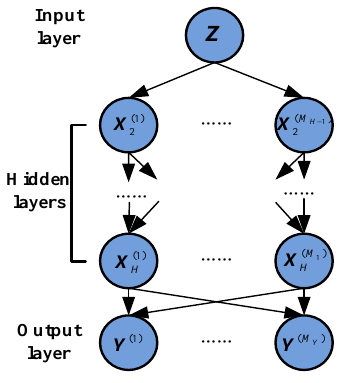
Figure 3. Graphic model of an extended DGP.